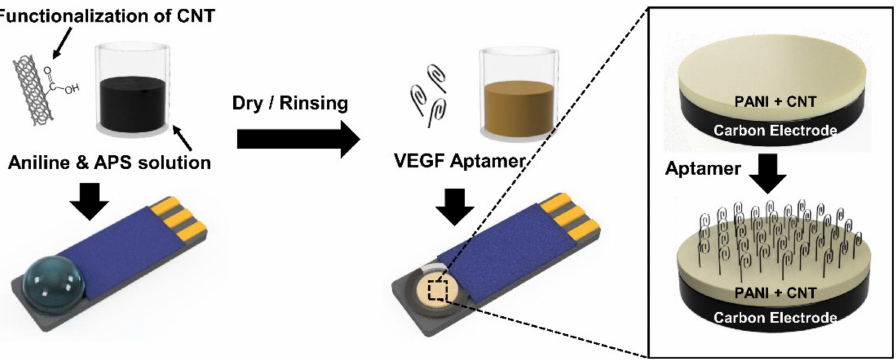
Figure 1. Schematic illustration of the preparation of the polyaniline/carbon nanotube (PANI/CNT) nanocomposite and the assembled VEGF 165 aptamer on the sensor surfaces for the VEGF